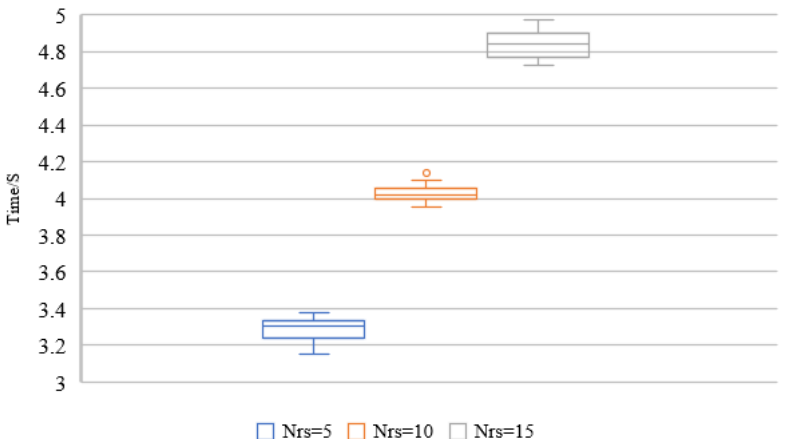
Figure 9. Box plots of time indicators.